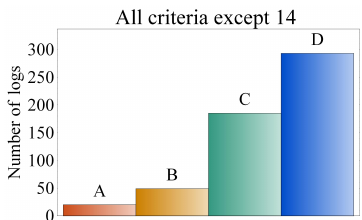
Figure 4. Results of visual grading with all characteristics minus the red heart characteristic (1–13,